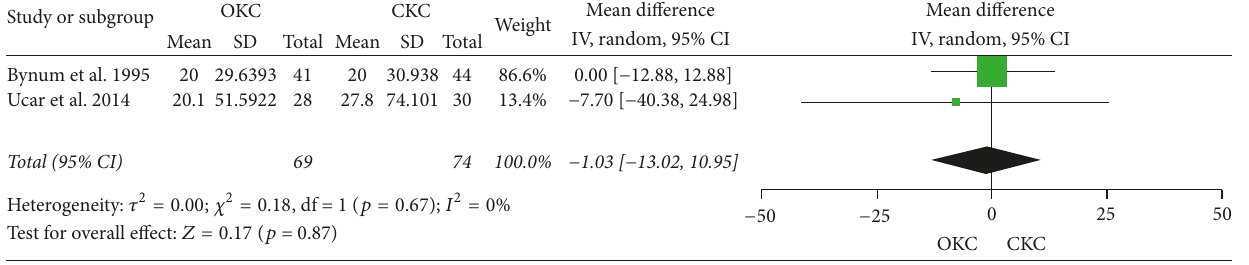
Figure 2: Lysholm score.